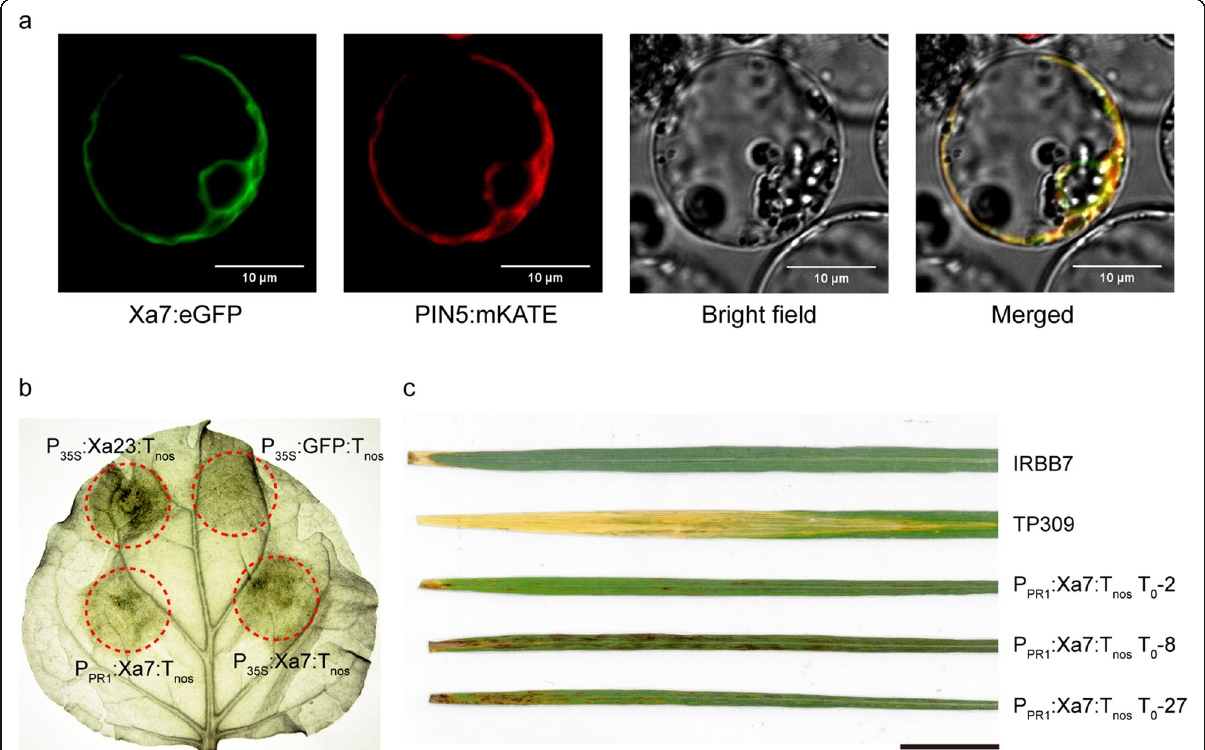
Fig. 5 XA7 elicits a hypersensitive response in rice and tobacco ( Nicotiana benthamiana ). ( a ) XA7 is anchored to the endoplasmic reticulum (ER) membrane and co-located with the ER marker PIN5 in rice protoplasts. ( b ) Xa7 expression induces cell death in the tobacco leaf following Agrobacterium tumefaciens – mediated infiltration. ( c ) Xa7 causes spontaneous lesions on rice leaves generated stably expressiong a P PR1 : Xa7 : T nos construction. Scale bar represents 5